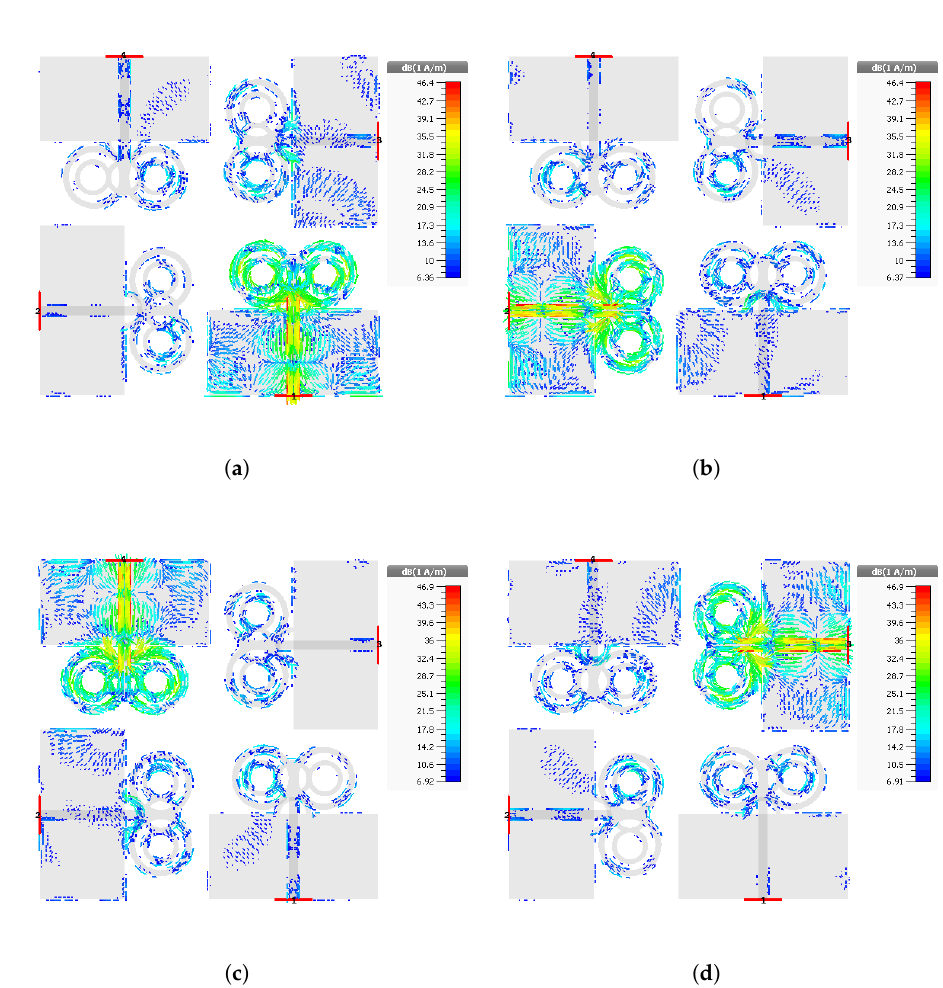
Figure 9. Distribution pattern of current at 28 GHz for ( a ) antenna 1, ( b ) antenna 2, ( c ) antenna 3, ( d ) antenna